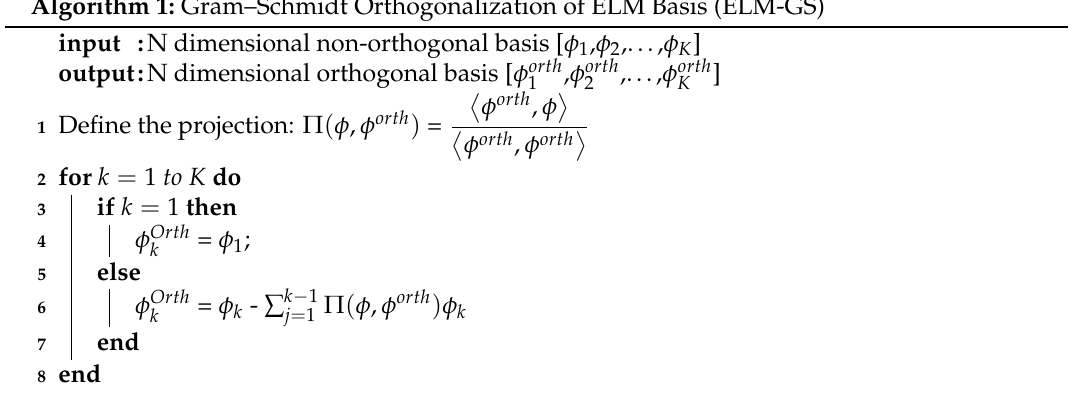
Algorithm 1: Gram–Schmidt Orthogonalization of ELM Basis (ELM-GS)